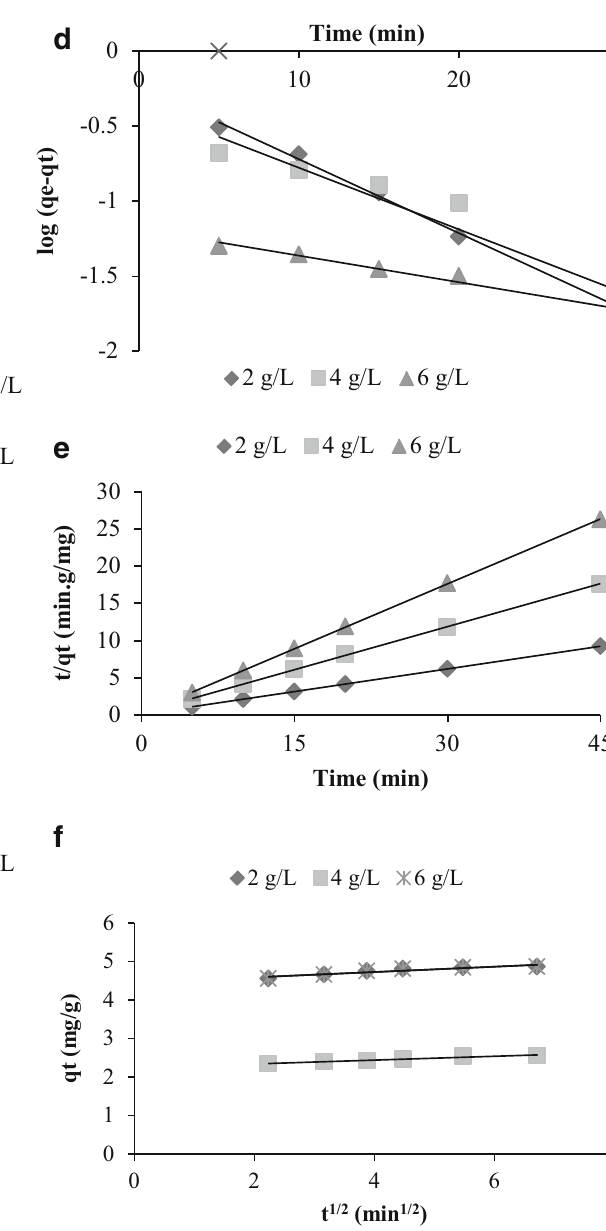
adsorbent dose was varied. e Pseudo-second-order kinetic model when adsorbent dose was varied. f Morris–Weber intra-particle diffusion model when adsorbent dose was